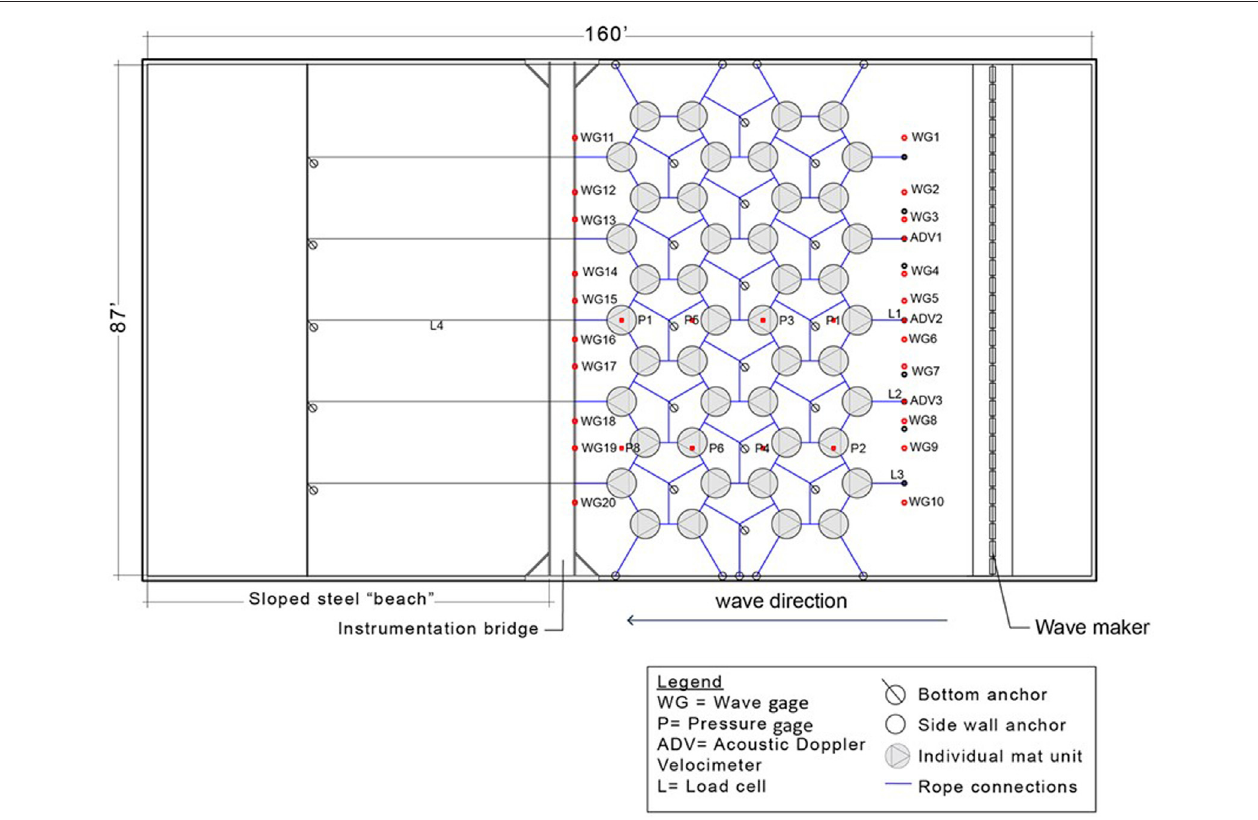
FIGURE 2 | Aerial view of the “ sparse ” Tutu network in the wave basin, with the wavemaker on the right and the beach on the left. The 5 ft diameter Tutu mats are show in grey, the dark blue lines are nylon connections between the mats and the anchors to the beach and side walls, empty circles with lines show bottom anchors, and the red dots show the location of instruments measuring hydrodynamic properties. The 1:10 sloped beach begins to the left of the instrumentation bridge. The instruments are labeled as shown in the legend to the bottom right.